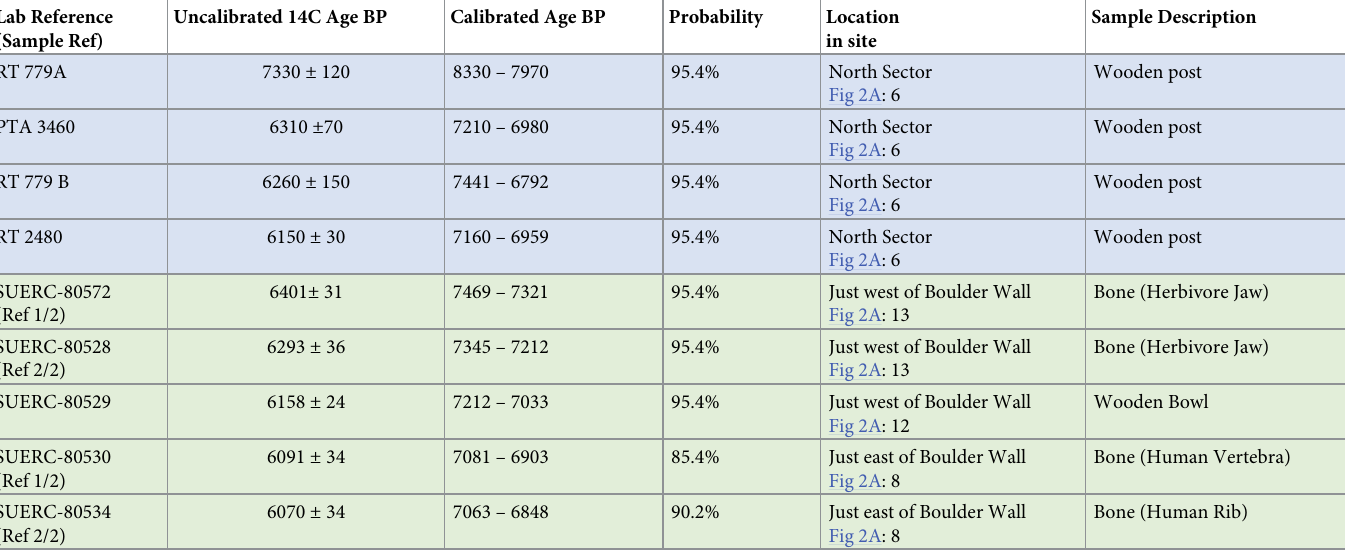
Table 1. Radiocarbon determinations from the Tel Hreiz late Pottery Neolithic